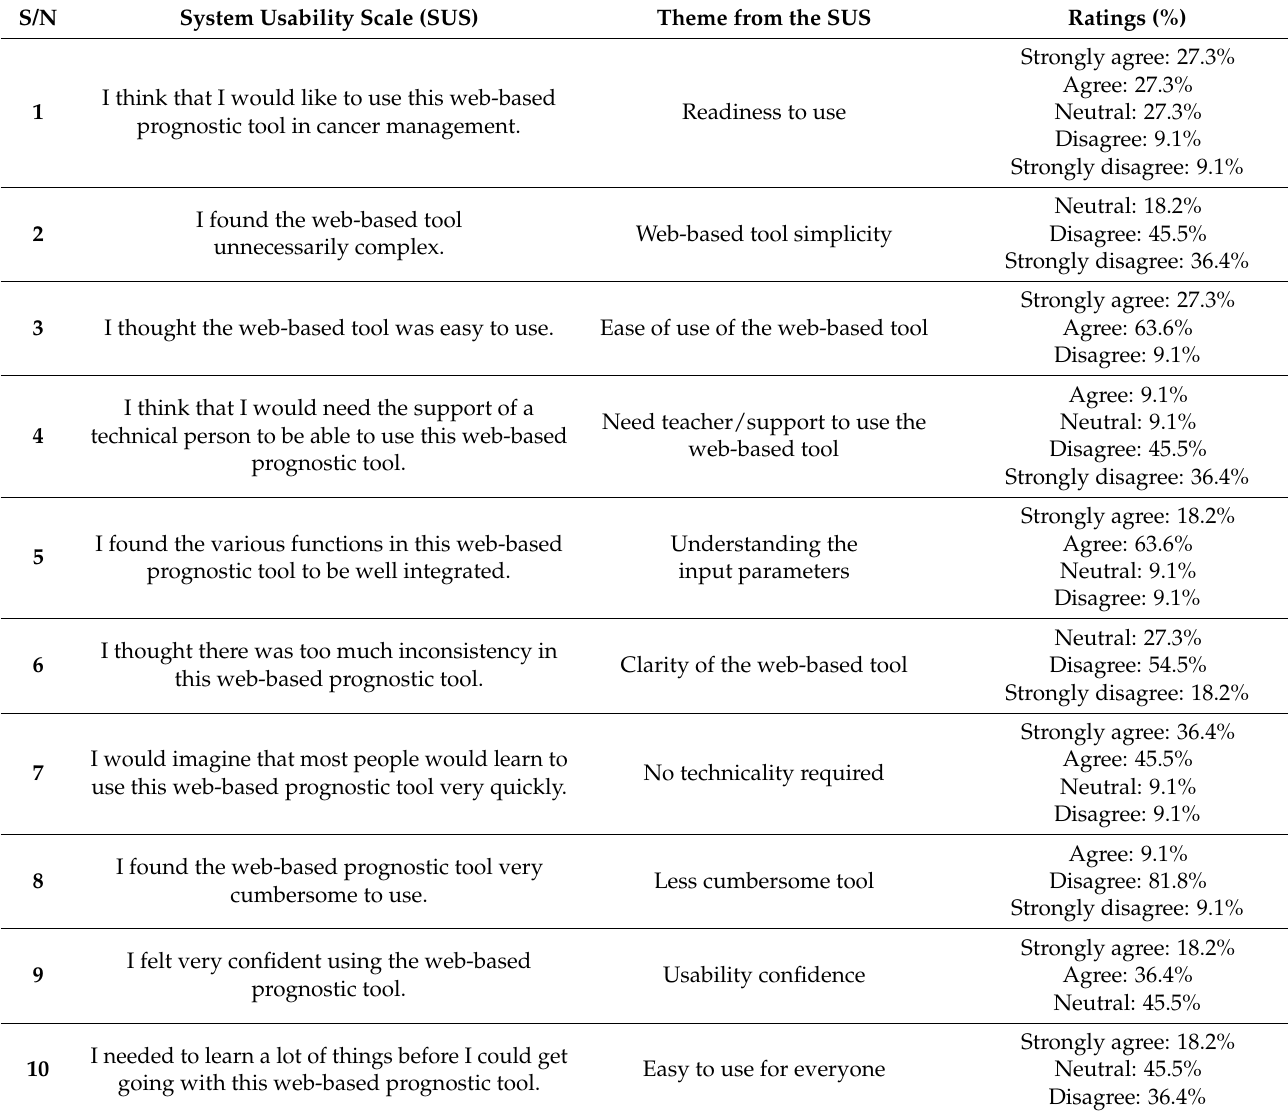
Table 1. Measuring the usability of a web-based tool the System Usability Scale (SUS) [12].